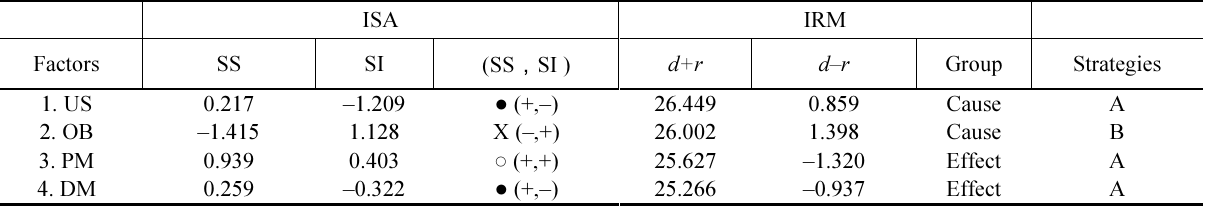
Table 13. Suggested strategies for improving delay factors